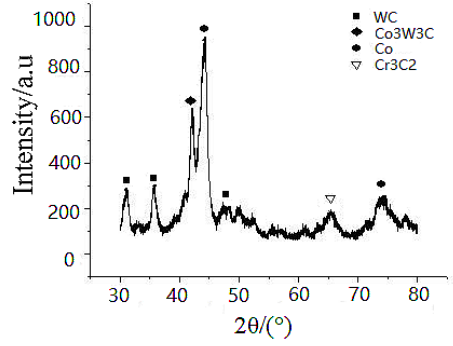
Figure 6. XRD spectrum of the sleeve ‐ pipe surface coating.